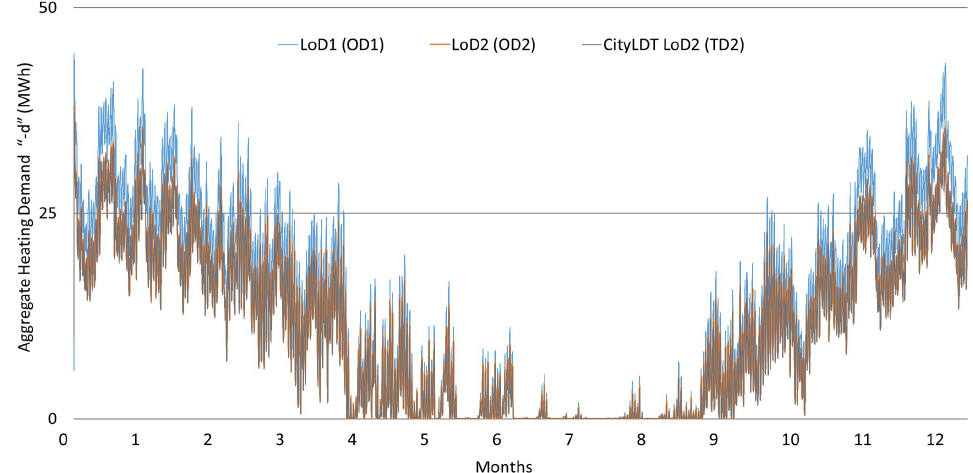
Figure 14. Overview of dynamic heating demand simulation (in MWh ) for the open LoD1 (OD1), LoD2 (OD2) and the transformed CityLDT LoD2 (TD2)